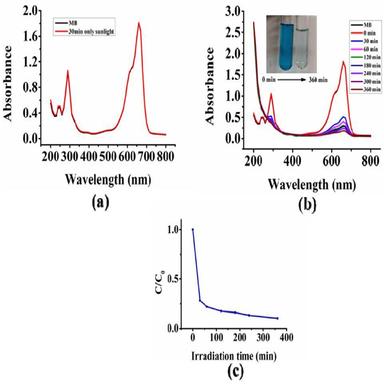
(a)UVevisible spectrum of MB dye and MB dye after 30min sunlight irradiation in absence of nanocomposite A(NC), (b) UVevisible spectrum of MB dye at different time intervals of sunlight irradiation in presence of nanocomposite A(NC) and (c) C/C0 with respect to sunlight irradiation time in presence of nanocomposite A(NC).